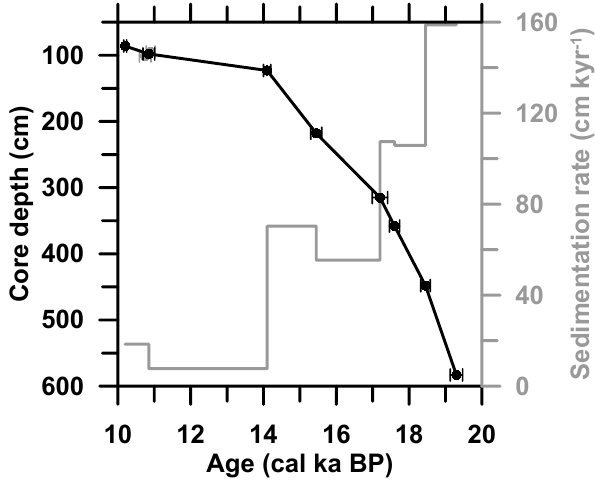
Figure 3. Age model and sedimentation rates for marine sediment core